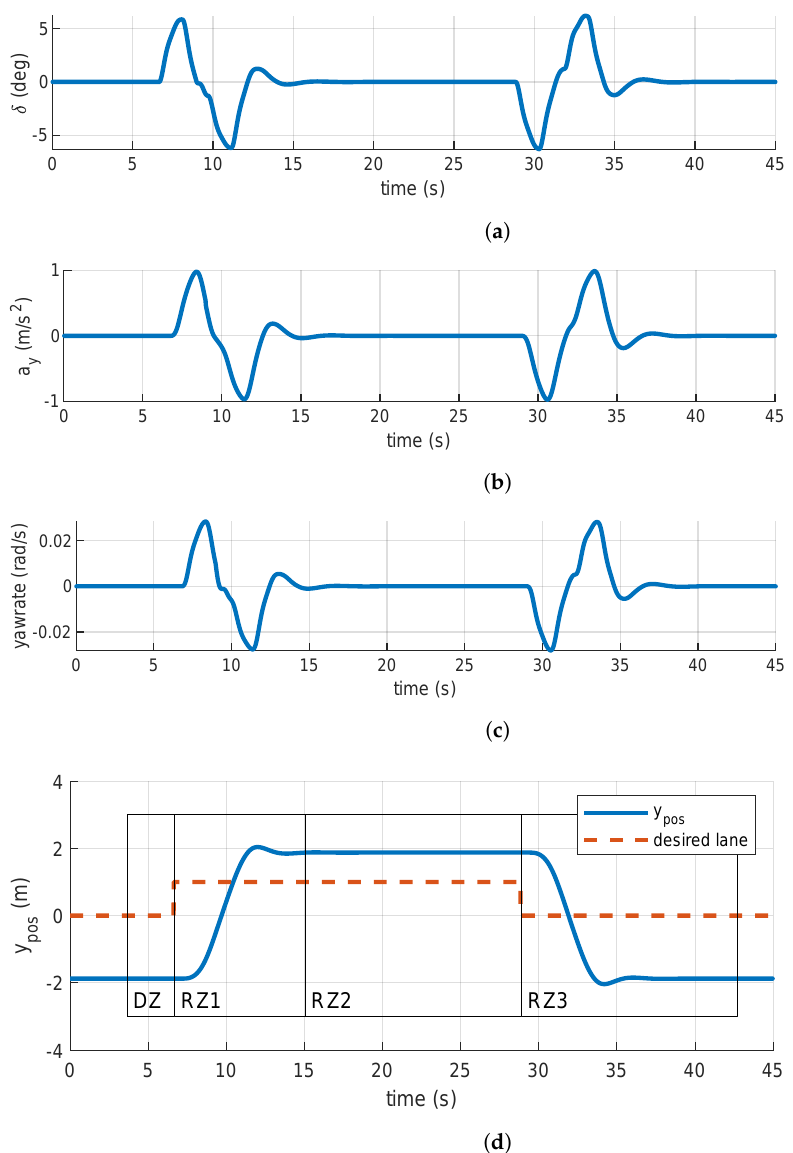
Figure 6. Result of the lane change recommendation scenario: ( a ) steering wheel angle, ( b ) lateral acceleration, ( c ) yaw rate, ( d ) lateral vehicle